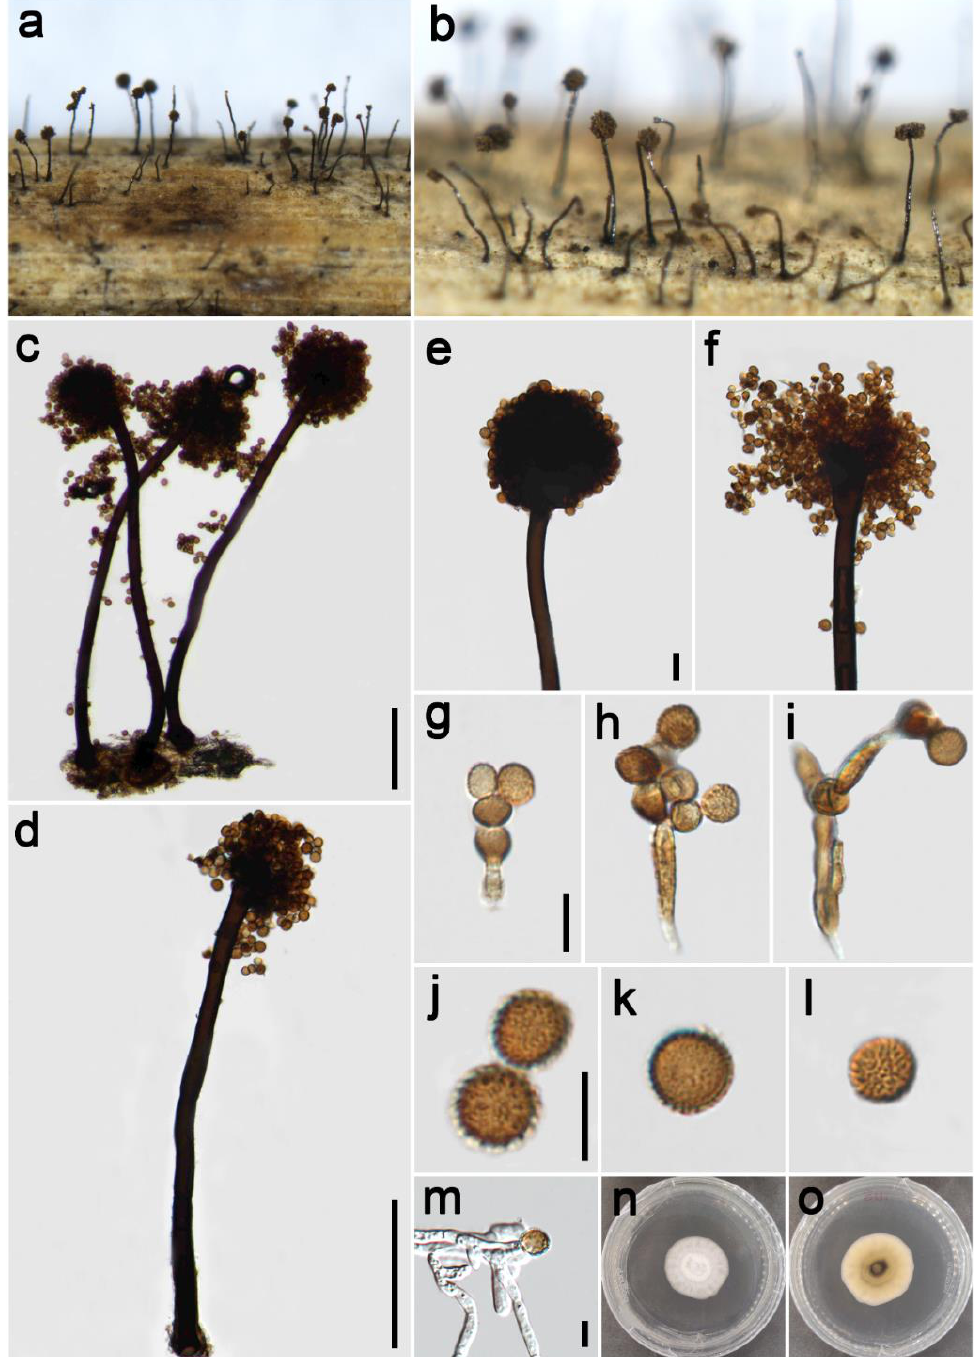
Figure 9. Periconia penniseti (HKAS 126518, holotype). ( a , b ) Colonies on the natural substrate; ( c , d ) conidiophores with spherical conidial heads; ( e , f ) conidial heads bearing conidiogenous cells and conidia; ( g – i ) conidiogenous cells bearing conidia in short chains; ( j – l ) conidia; ( m ) germinating conidium; ( n , o ) colony on PDA from above and below. Scale bars: ( c , d ) = 100 µm, ( e , g , j , m ) = 10 µm. Scale bar of ( e ) applies to ( f ). Scale bar of ( g ) applies to ( h , i ). Scale bar of ( j ) applies to ( k , l ). Periconia pseudobyssoides Markovsk. and A. Kačergius, Mycol. Progr. 13(2): 293 (2014) Figure 10.